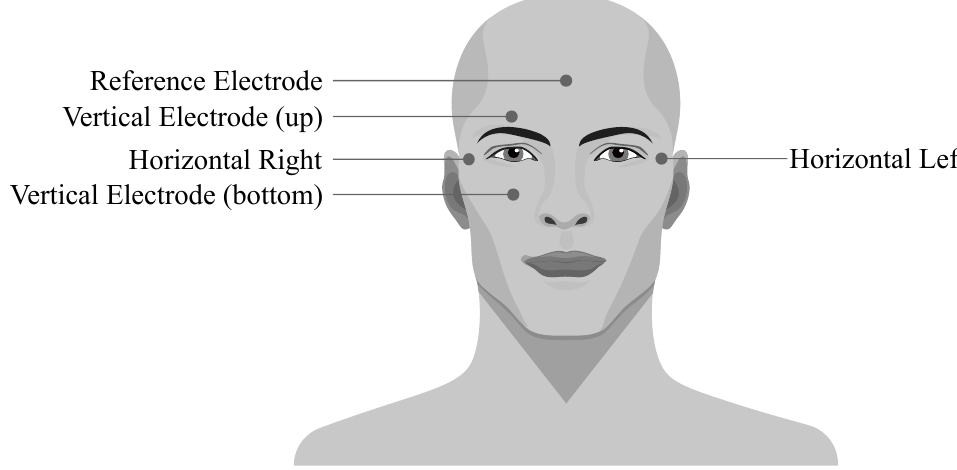
Figure 9. Placement of the EOG